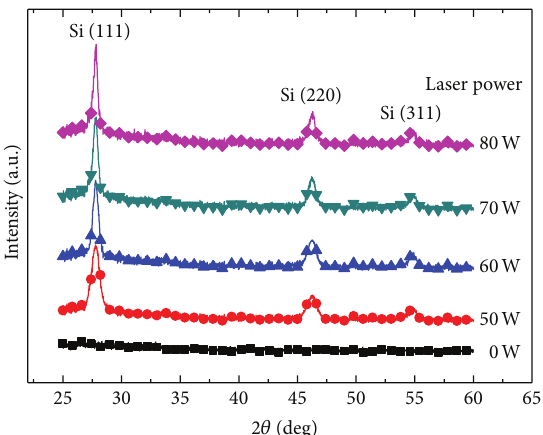
Figure5:Micro-Ramanscatteringspectraofthei-Sifilmsdeposited with various assisting laser powers.